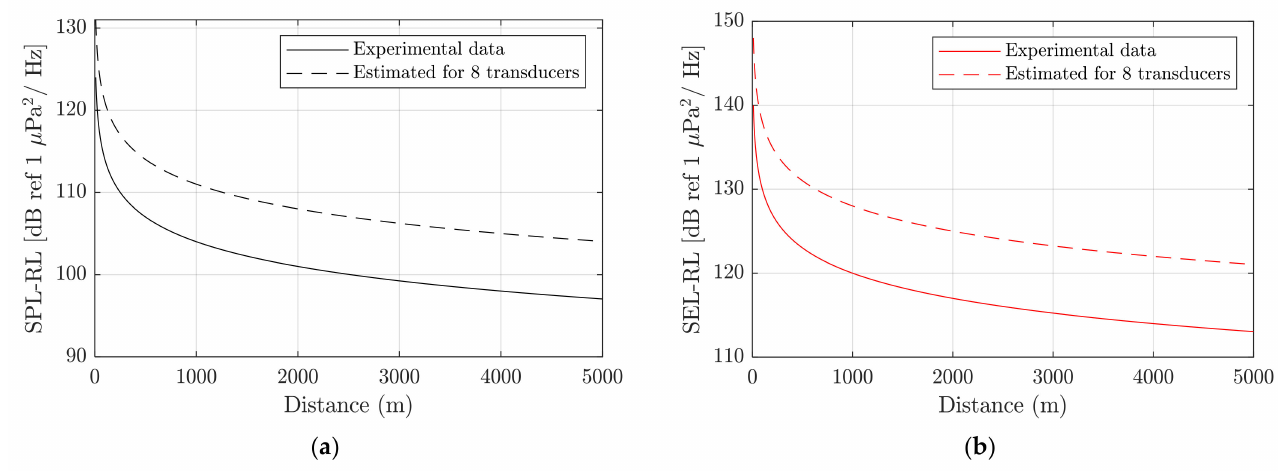
Figure 16. Received levels in terms of ( a ) sound pressure level (SPL) and ( b ) sound exposure level (SEL) produced by arrays of